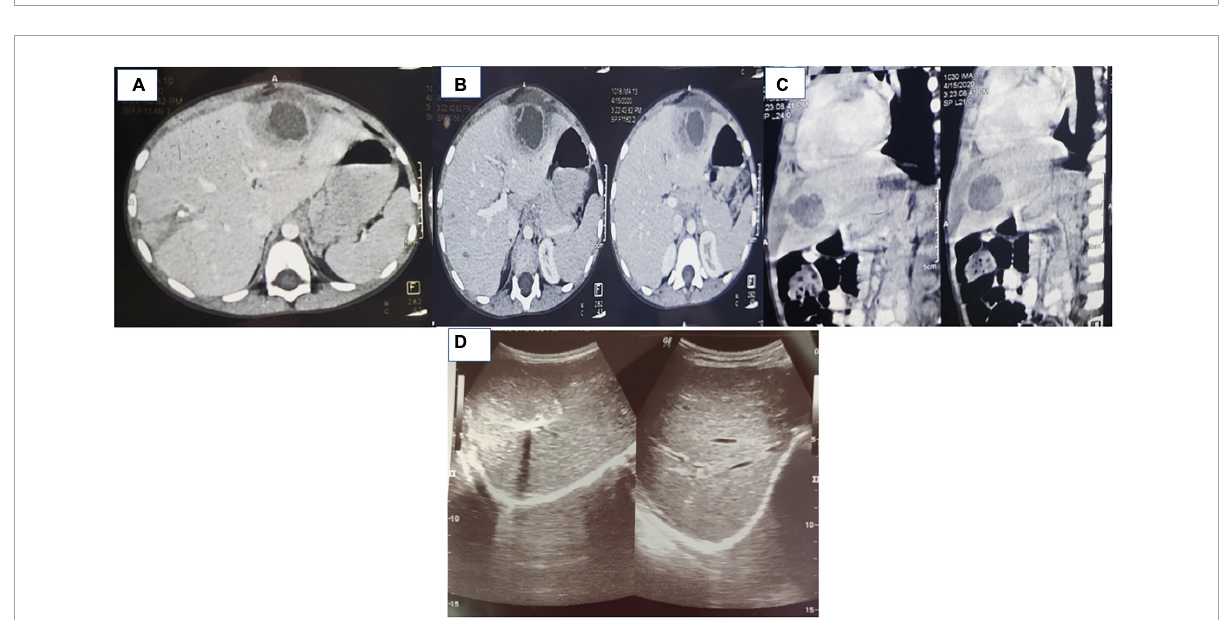
FIGURE2 (A–C) Computed tomography of case 2 showing a hypoattenuating focal lesion with thick/shaggy walls with perilesional edema suggestive of abscess in the liver, arrow marks. (D) Ultrasound images of case 2 showing resolution of abscess following initiation of corticosteroids (after 6 weeks of initiation of